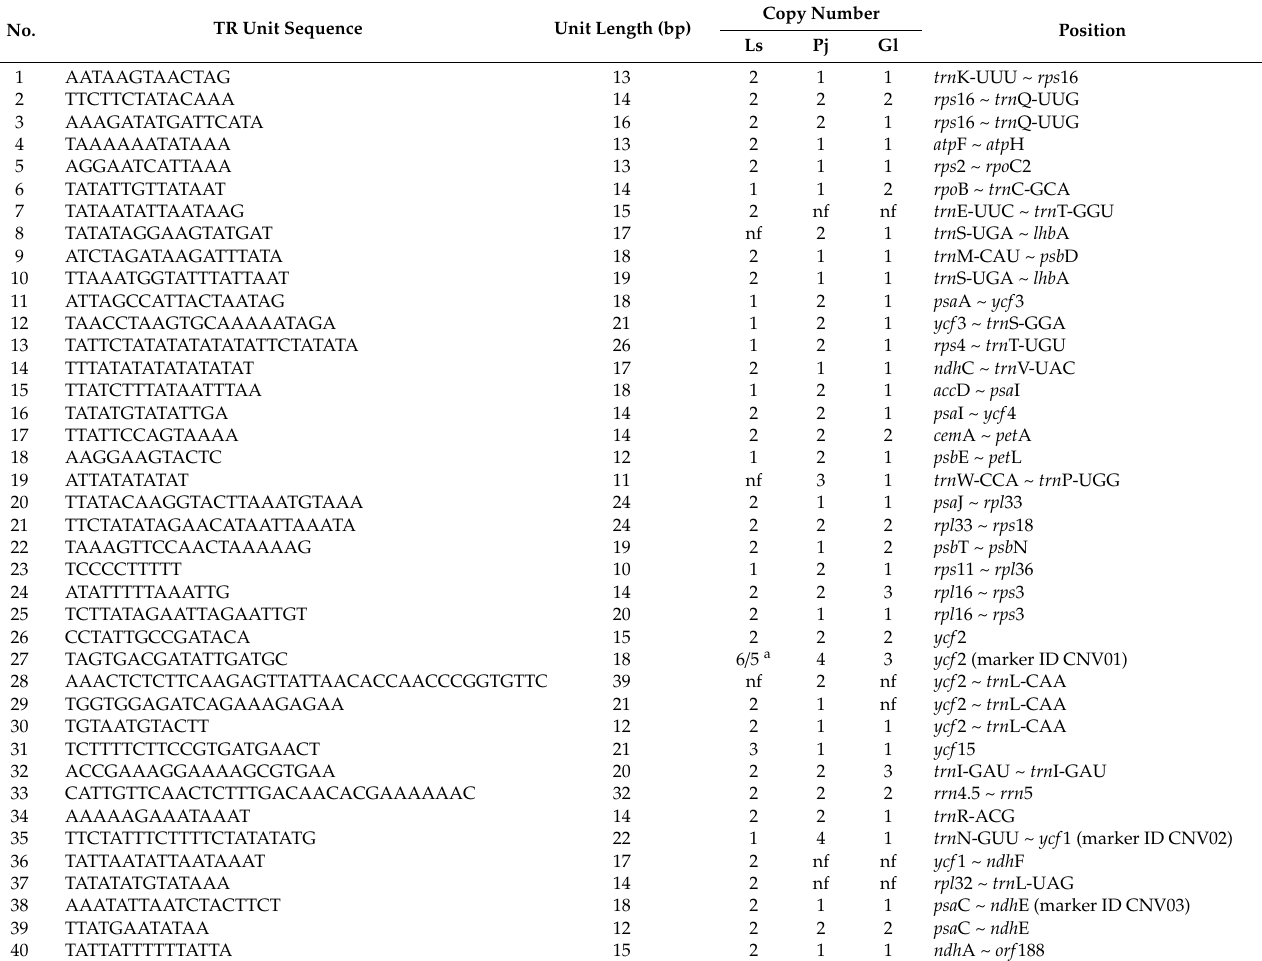
Table 2. Copy number variations of tandem repeat (TR) units in chloroplast (cp) genomes among three Apiaceae species.